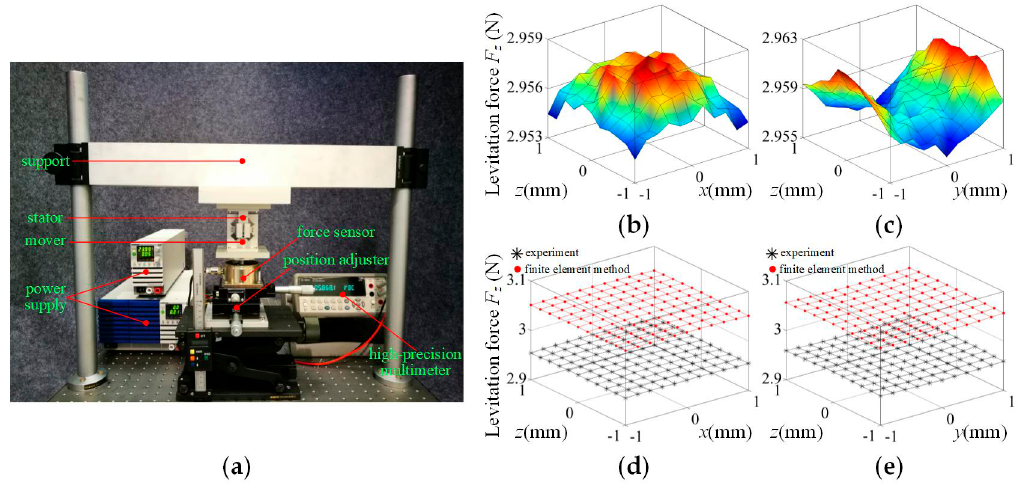
Figure 15. Test installation, and comparison between the test result and FEA result. ( a ) Test installation. ( b ) Test result of output force F z vs. z and x . ( c ) Test result of output force F z vs. z and y . ( d ) Comparison between the test result and FEA result of F z vs. z and x . ( e ) Comparison between the test result and FEA result of F z vs. z and y .